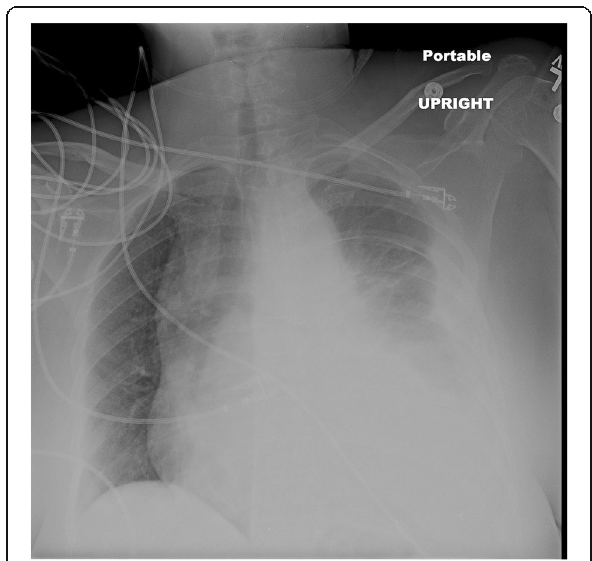
Fig. 1 Initial chest x ray showing widened mediastinum, opacification of left hemithorax & rightward mediastinal shift